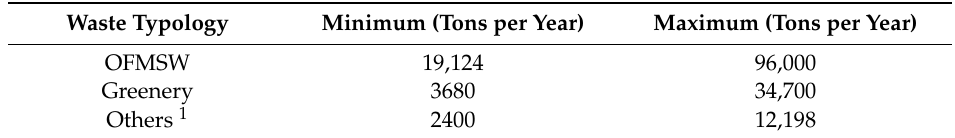
Table 1. Minimum and maximum quantity of waste processed in tons per year (OFMSW = organic fraction of municipal solid waste).